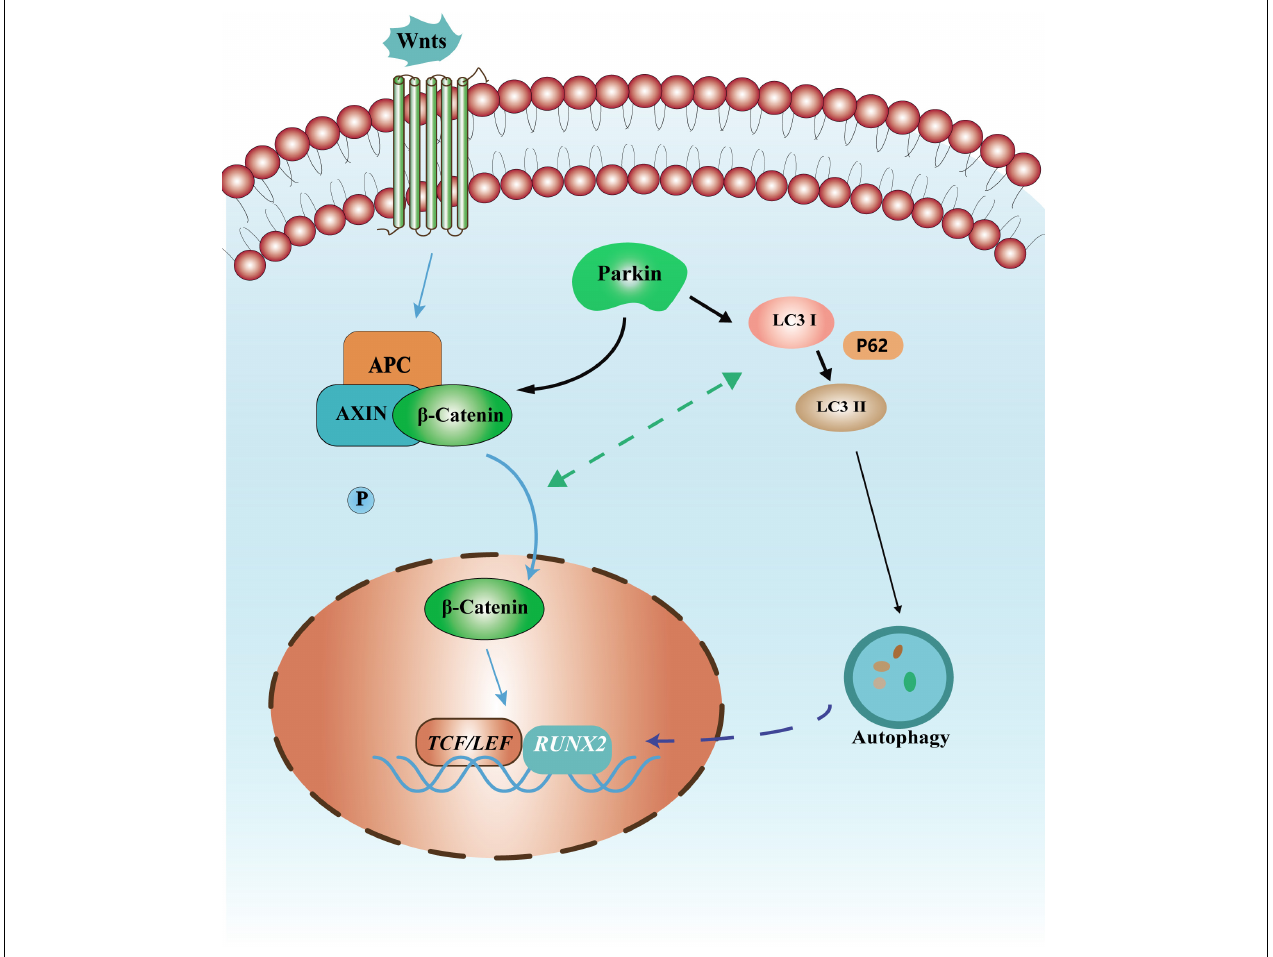
FIGURE 6 | Schematic diagram of the mechanism of osteoblastic differentiation induced by Parkin in this study. Parkin regulates the osteoblastic differentiation of BMSCs via autophagy and β -catenin